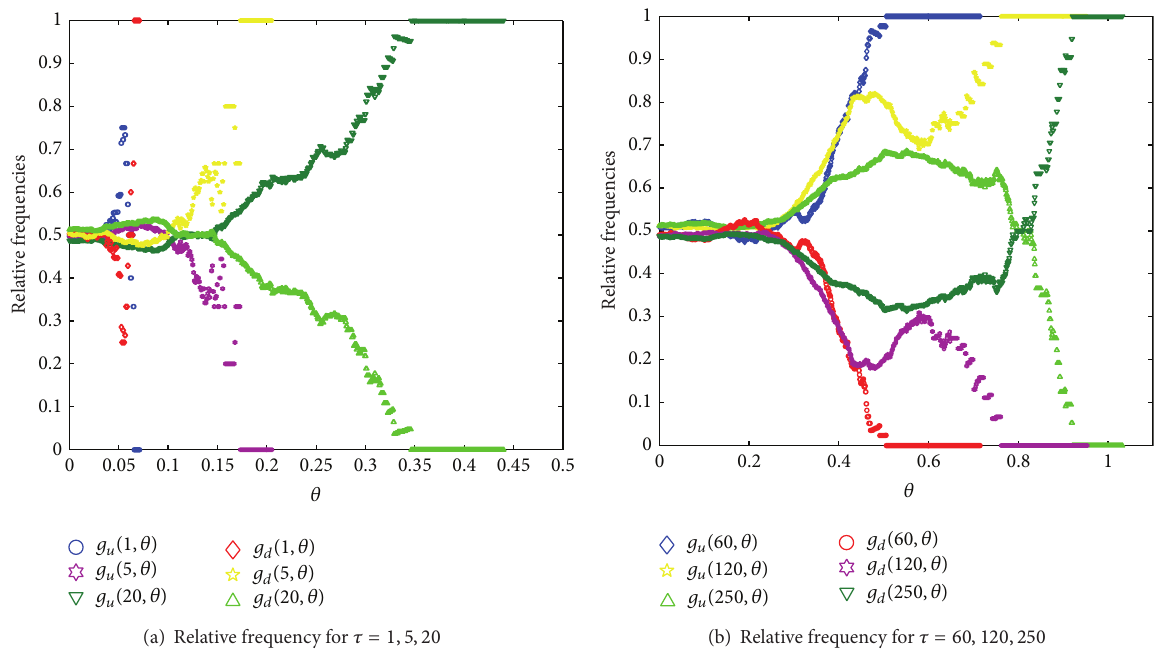
Figure 4: The evolution trends of relative frequencies of the simulation data for financial model with the random variable 𝜃 .